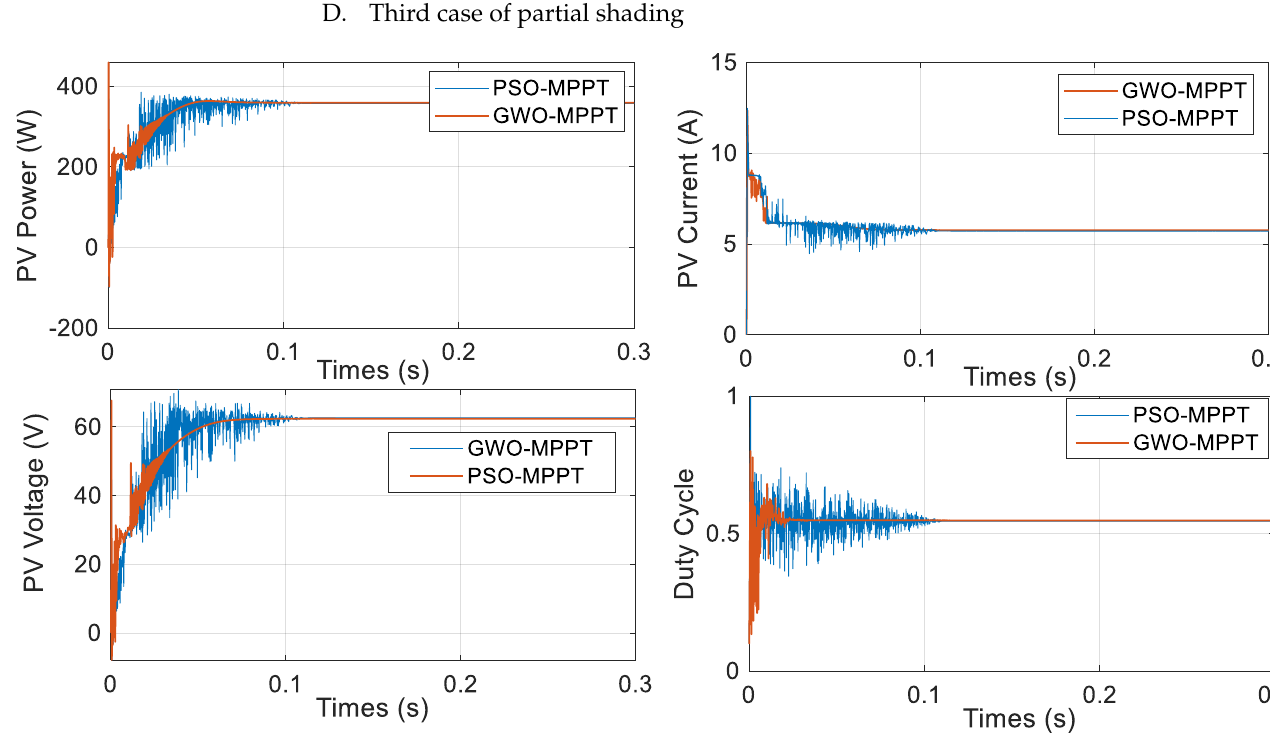
Figure 13. PV characteristics under partial shading: (200 W/m 2 , 300 W/m 2 , 700 W/m 2 , 1000 W/m 2 ).